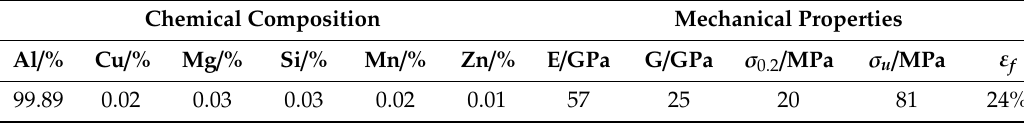
Figure 1. Metallographic image of the polycrystal aluminum. Figure 2. Specimen geometry of pure aluminum (unit: mm). Table 1. Chemical compositions and mechanical properties of polycrystalline aluminum.